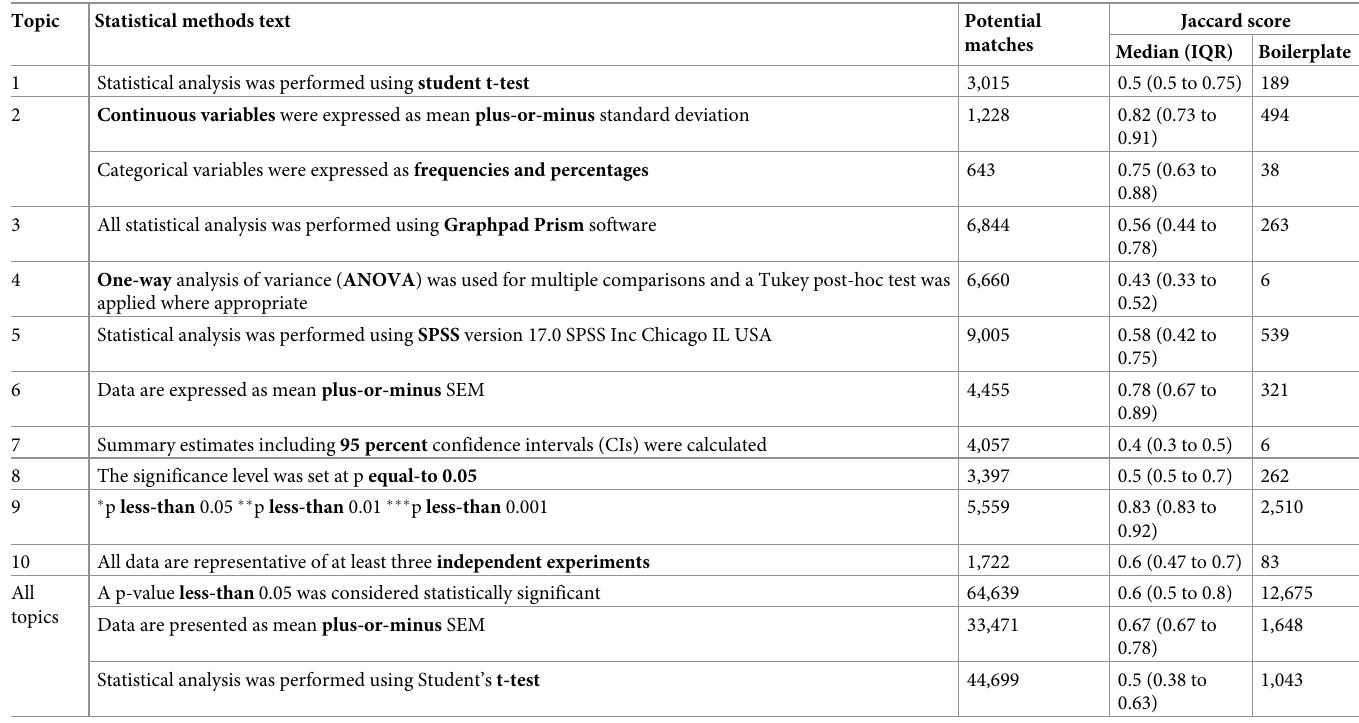
Table 1. Examples of boilerplate text from PLOS ONE papers based on targeted n-gram searches (sentence level).